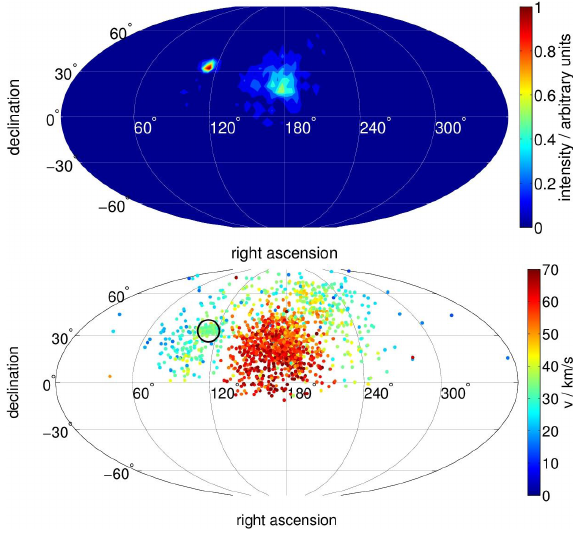
Fig. 13. Top: MAARSY radiant intensity plot normalized to Gem- inid source radiant. Bottom: head echo radiant distribution with color coded velocity.